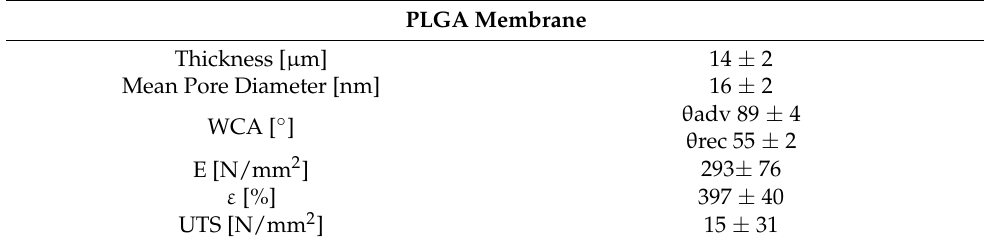
Table 1. Poly(lactic-co-glycolic acid) (PLGA) membrane properties. Advancing ( θ adv) and receding ( θ rec) water contact angle (WCA); Young’s modulus (E); elongation at break ( ε ) and ultimate tensile strength